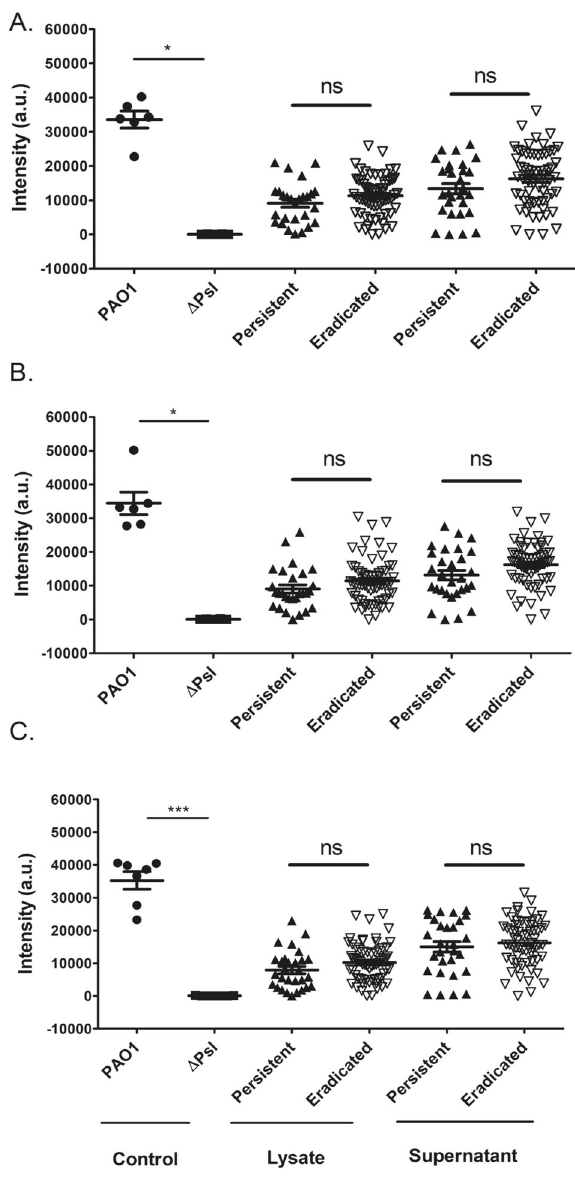
Fig. 1 Dot blot analysis of Psl levels in persistent ( N = 29, black triangles) versus eradicated ( N = 63, white triangles) P. aerugi- nosa isolates from SickKids cohort. SickKids P. aeruginosa isolates, PAO1 and Δ Psl (Psl de fi cient P. aeruginosa ) were grown as bio fi lms. The supernatant and lysate were spotted on nitrocellulose membrane and incubated with Cam003 ( A ), WapR001 ( B ) or WapR016 ( C ) anti-Psl antibodies. Bound antibody was detected with a chemiluminescent substrate after secondary antibody incubation, and signal intensities were analyzed using the ChemiDoc Imaging System. The mean intensity values for each isolate (done